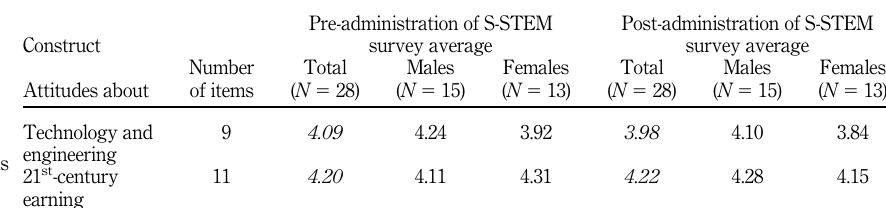
attitudes by construct averages between survey administrations disaggregated by gender (male and